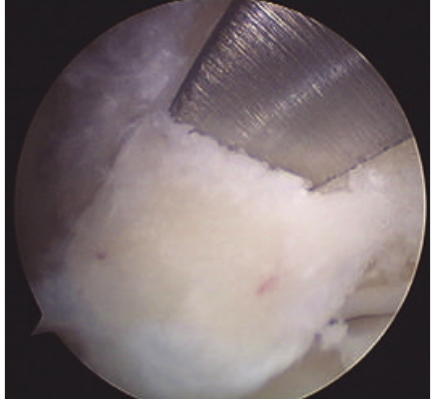
Figure 5: Resection of posterior talar process using a